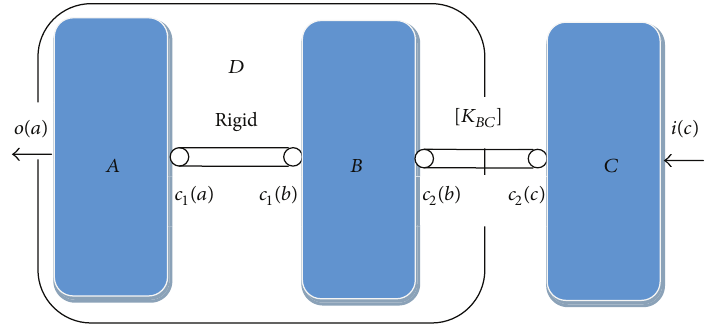
Figure 2: Single-coordinate coupled three-substructure